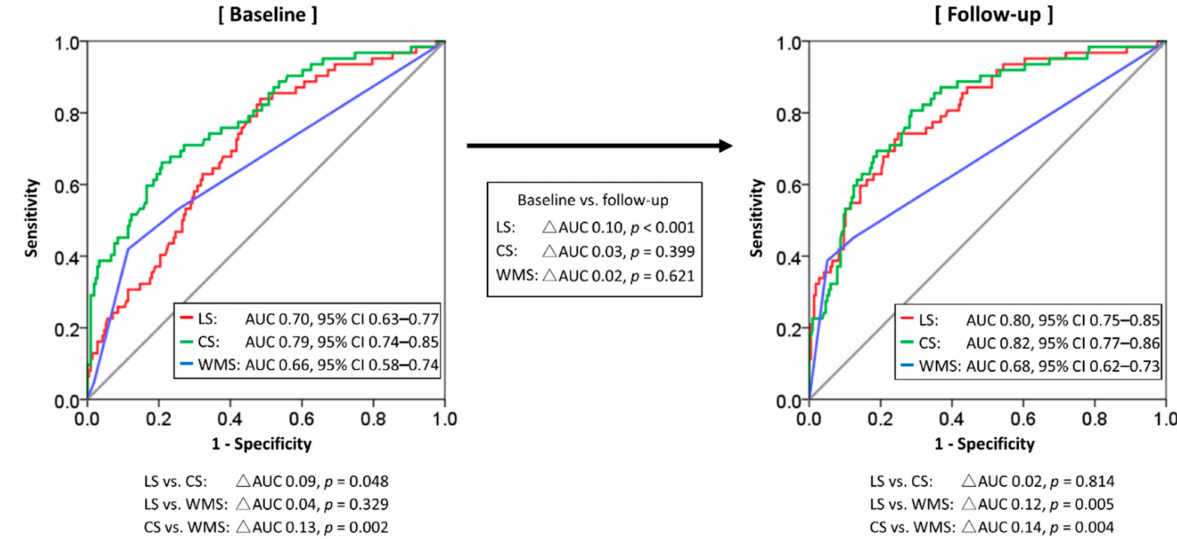
Figure 4. Comparisons of discriminatory accuracy of echocardiographic parameters at baseline and follow-up for nonviable segments in LGE MRI images prior to the procedure. Abbreviations: AUC, area under the curve; CS, circumferential strain; LS, longitudinal strain; WMS, wall motion score.